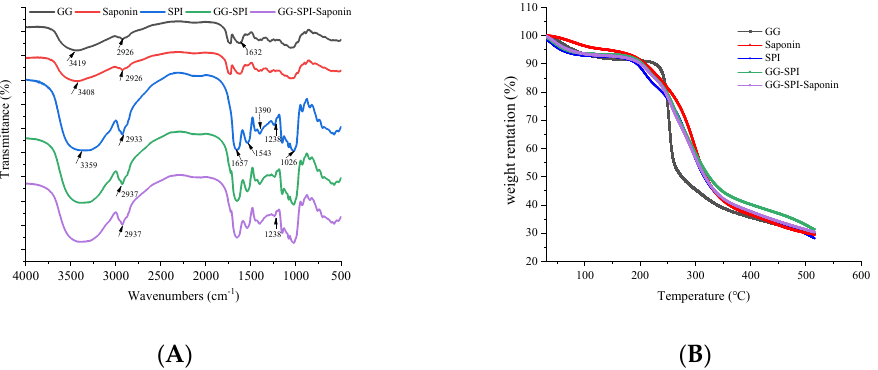
Figure 4. Structural characteristics of composite gel. ( A ) FT-IR spectra of GG, SPI, saponin, GG-SPI, and GG/SPI-saponin; ( B ) TGA thermograms of GG, SPI, saponin, GG-SPI, and GG/SPI-saponin.